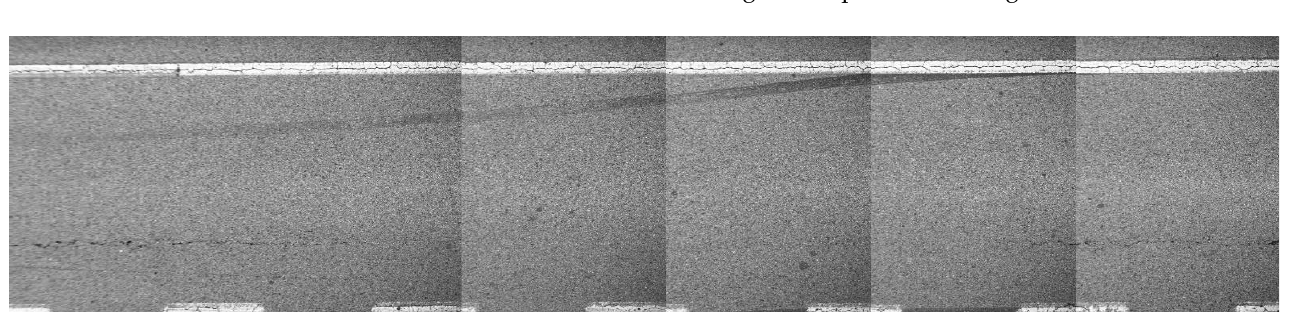
11 of 21 Figure 9. Sample of a panoramic image.